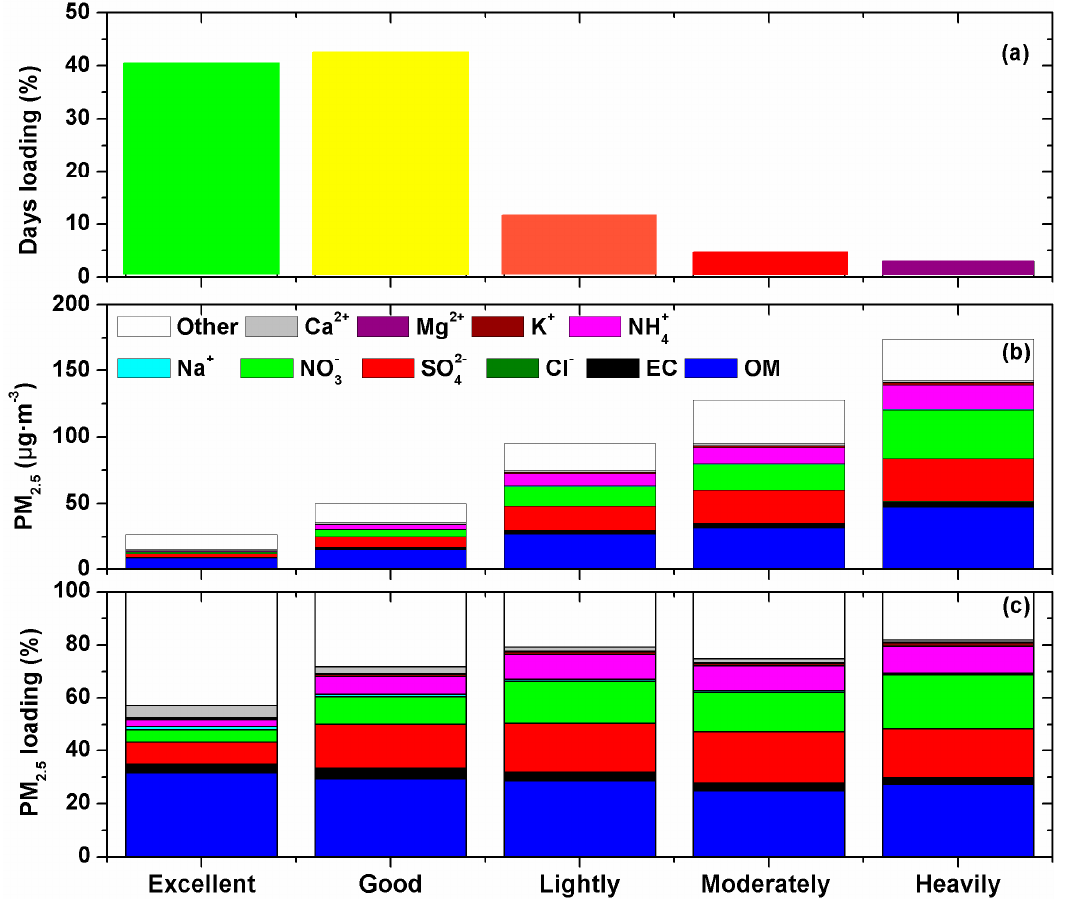
Figure 6. Percentage of days ( a ); mass concentrations of major chemical components in PM 2.5 ( b ); and mass fractions of major chemical components in PM 2.5 ( c ) under different pollution levels at SDZ station.